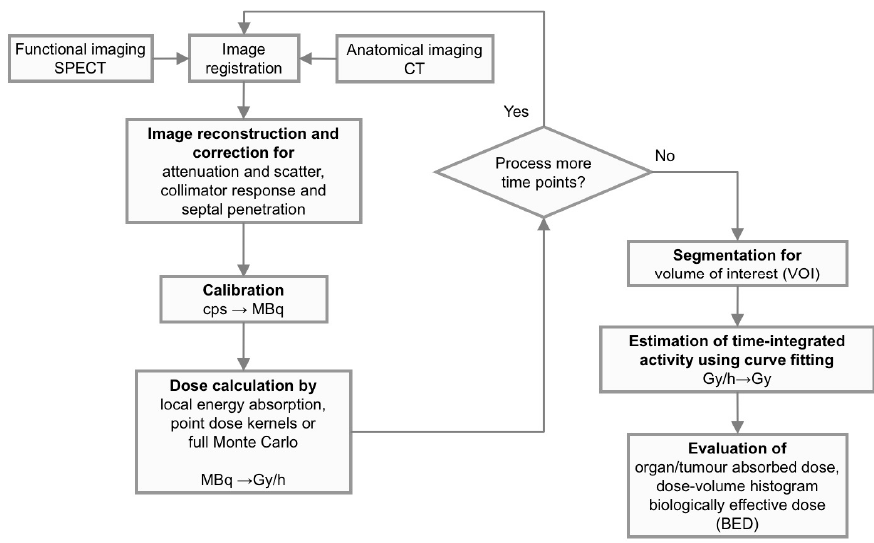
Figure 7. A flow-chart describing the essential steps needed to obtain quantitative 3D activity and related absorbed-dose images. If using a combined SPECT/CT system, explicit registration of SPECT and CT images is not required, since positioning and interpolation are inherent in the imaging